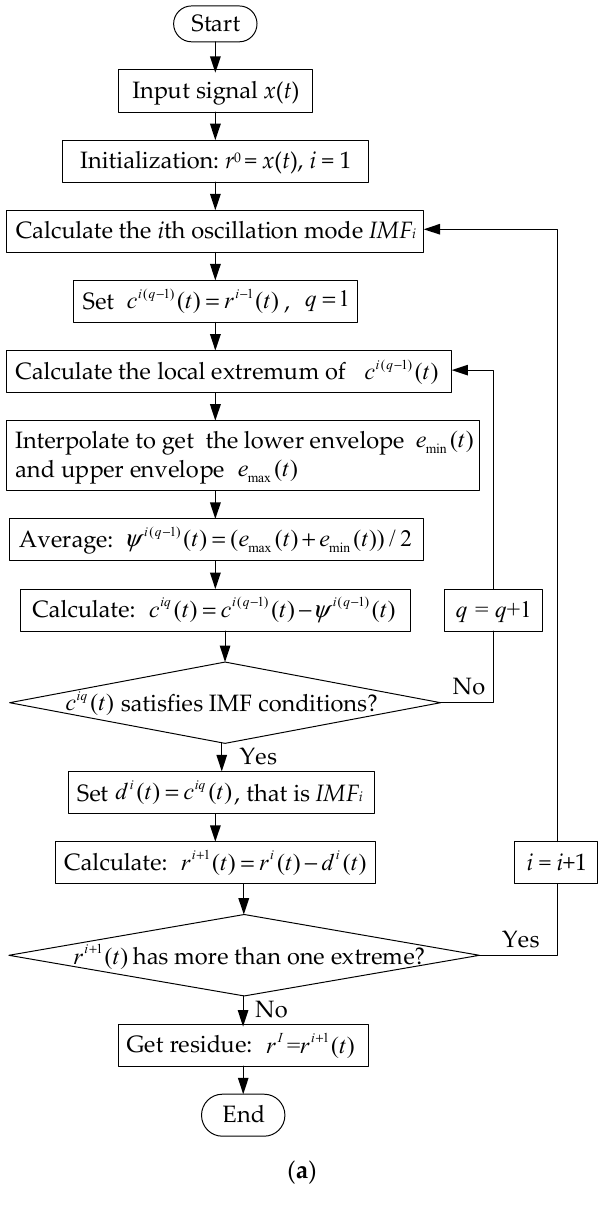
Figure 3. The block diagrams of EMD algorithm and EEMD algorithm. ( a ) EMD; ( b ) EEMD.